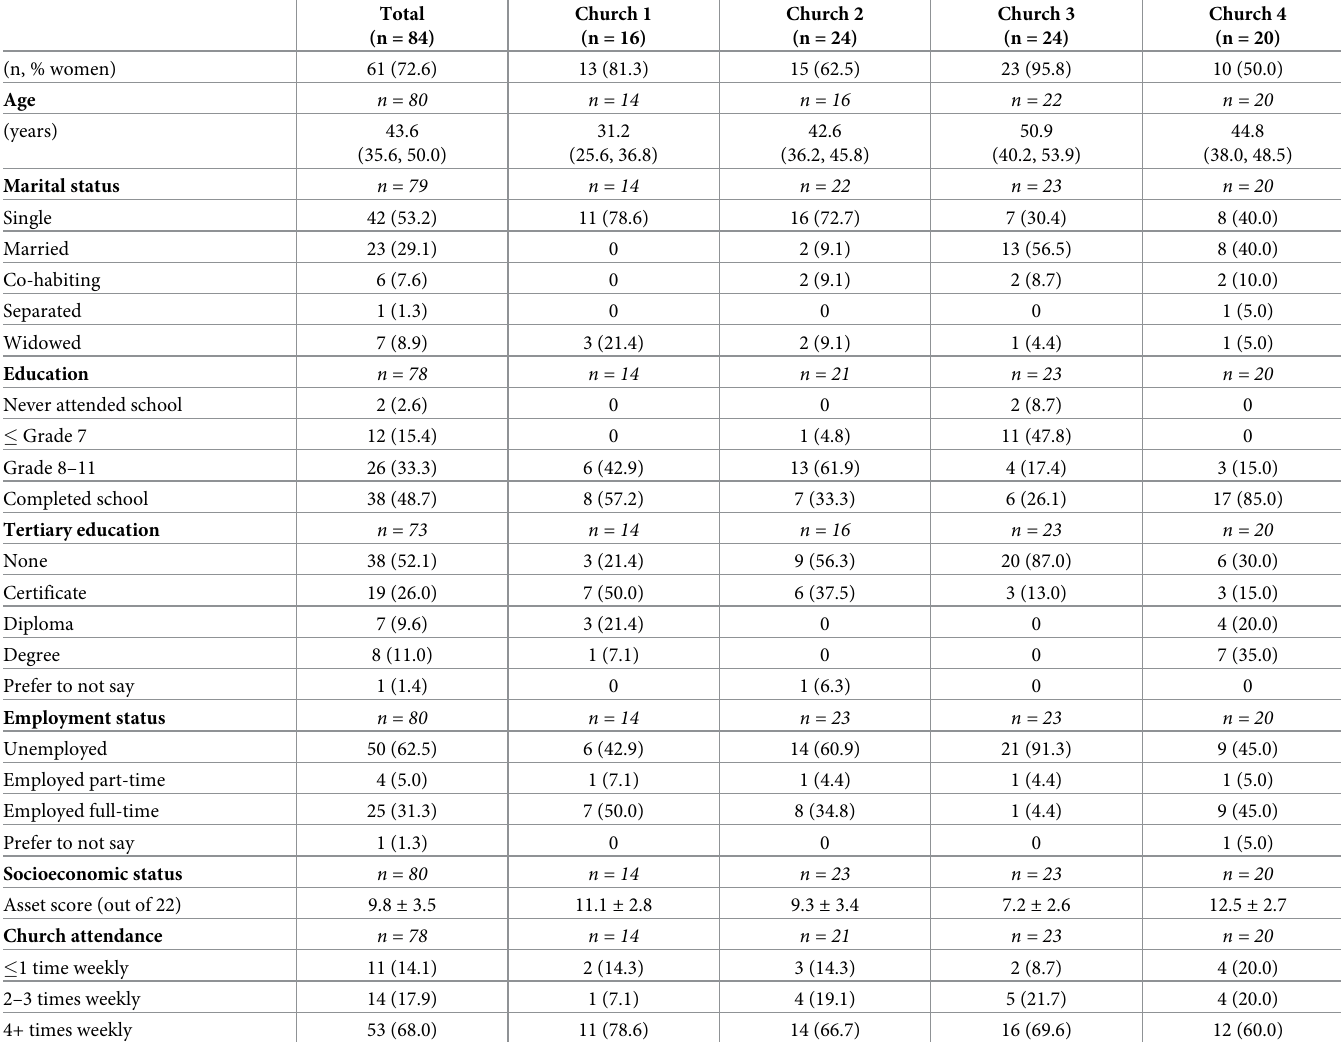
Table 5. Participants’ socio-demographic characteristics (total sample at baseline) �